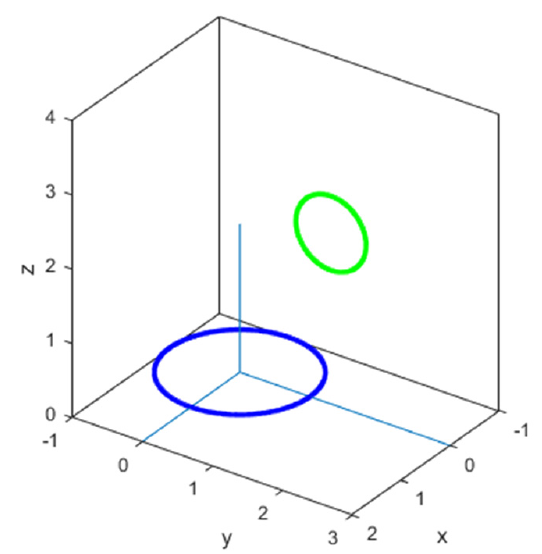
Figure 5. Case (a): two perpendicular circular loops. Not a singular case, ( a = 1, b = c = 0, L = l = 1).